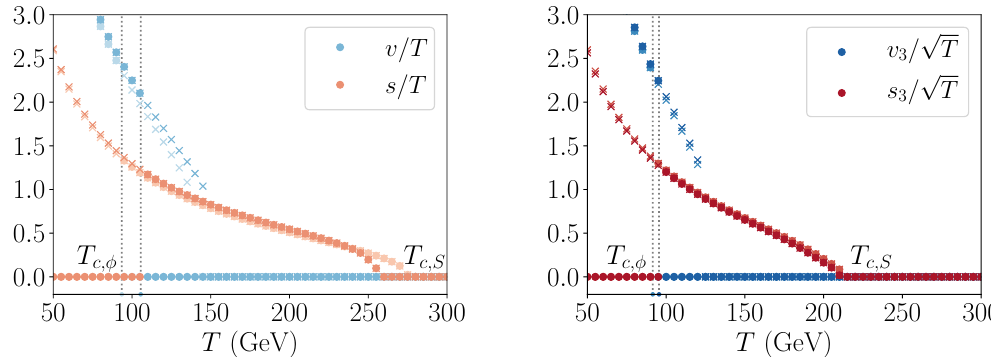
Figure 1 . Minima of the real part of the effective potential as a function of the temperature, determined in a one-loop approximation (left) and at two-loop within the 3d EFT with NLO dimensional reduction (right). Blue (red) denotes the Higgs (singlet) direction, and dots (crosses) present global (local) minima. Local minima describe the metastable phases. The different dark and light colours present two choices for the 4d RG scale µ : 0 . 5 πT and 2 πT . The vertical lines depict the critical temperatures for the second transition ( T c,φ ), and the band between them the theoretical uncertainty in their determination. We note that the critical temperatures for the first transition ( T c,S ) is very sensitive to two-loop corrections, while T c,φ is